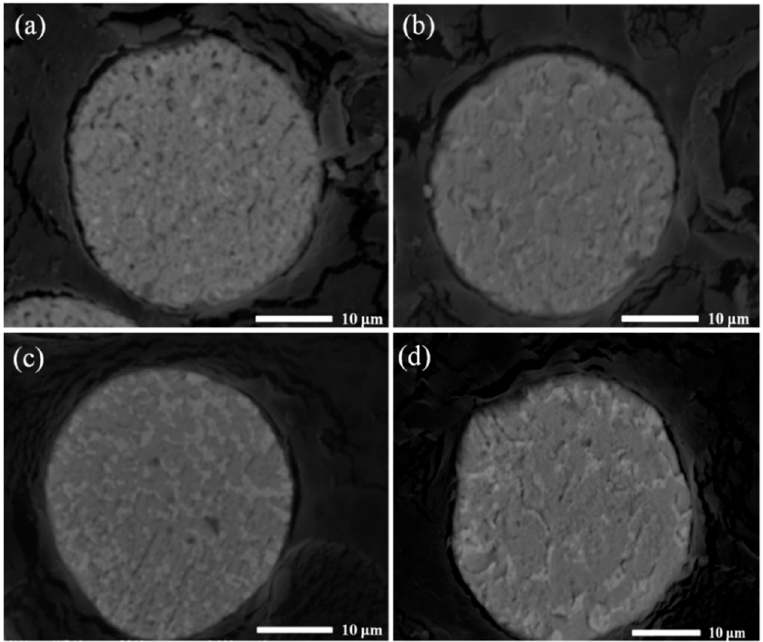
Figure 4. Cross-sectional microstructure of rapidly solidified Sn–Pb37 powder after aging for ( a ) 7, ( b ) 21, ( c ) 29, and ( d ) 40 days.